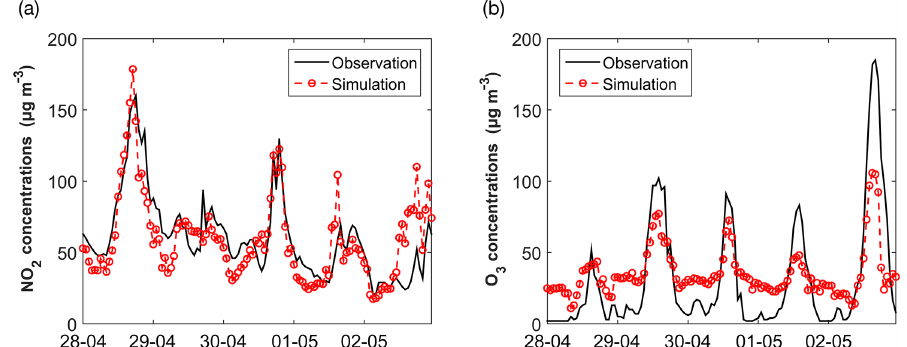
Figure 12. Time series of (a) NO 2 and (b) O 3 during the simulation period. (solid black line: observation; dashed red line: simulation).